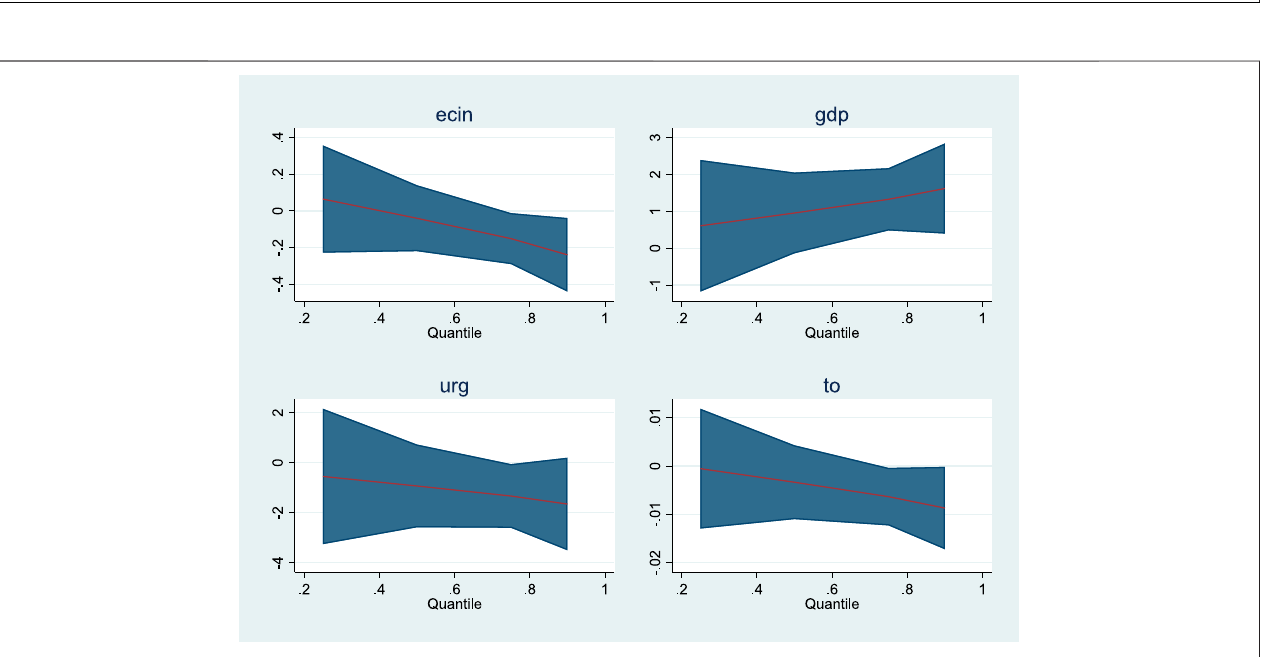
FIGURE 2 | Graphical presentation of quantile regression for Model 1.